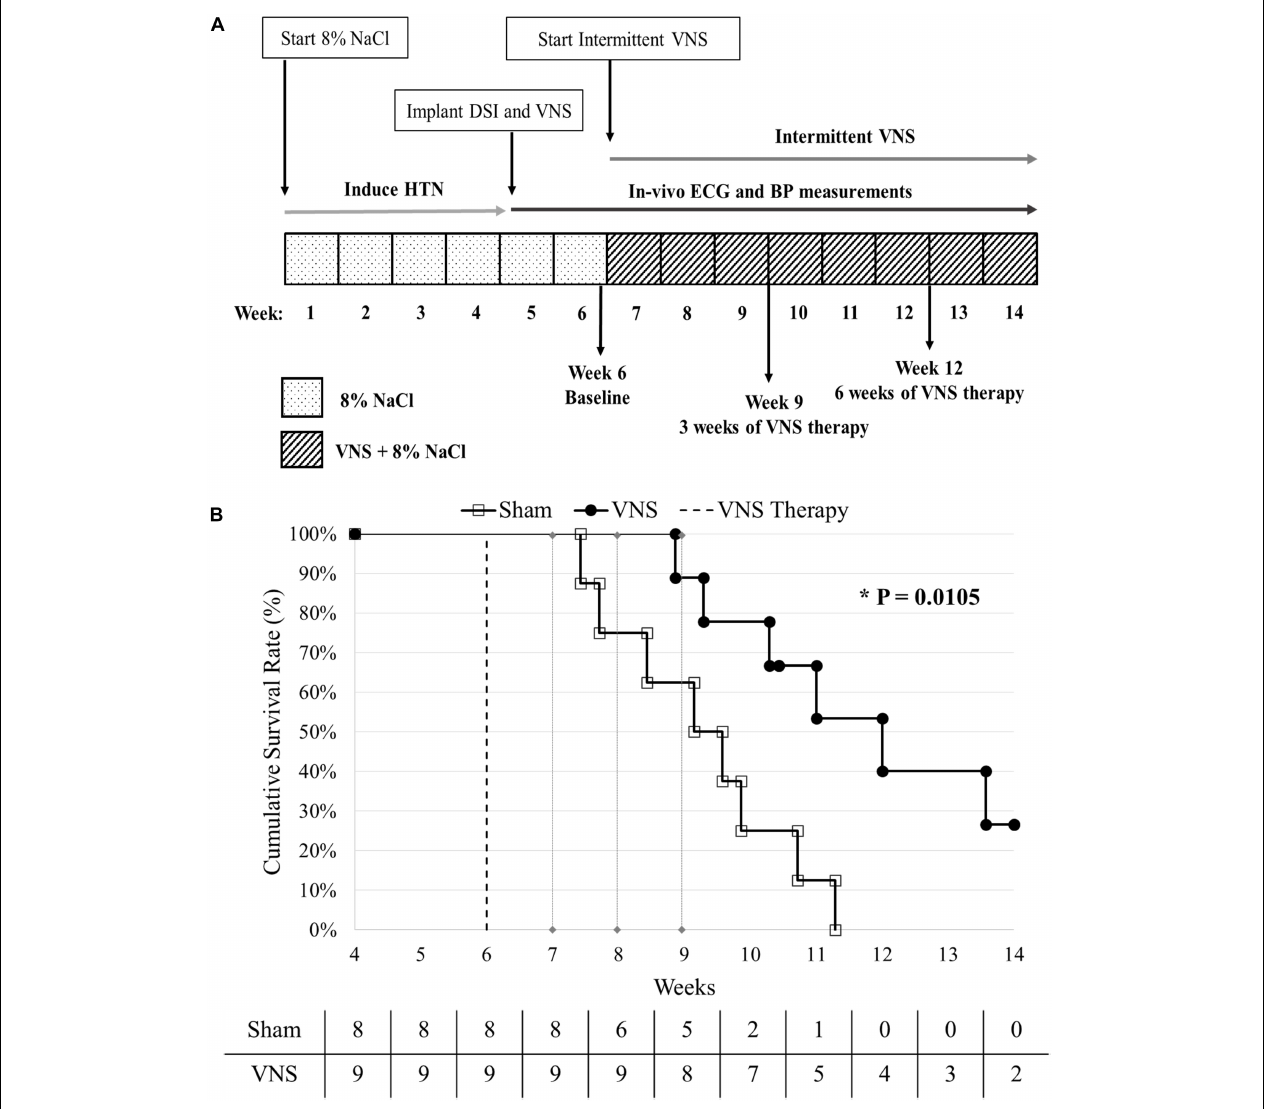
FIGURE 1 | (A) Experimental design. HTN was induced using a high salt diet (8% NaCl). At Week 4, the rats were implanted with vagal nerve stimulators and DSI transmitters, and randomly divided into Sham ( n = 8) and VNS ( n = 9) groups. VNS therapy was turned on at Week 6 and continuous BP and ECG were recorded until the end of the study. (B) Kaplan-Meier event-free survival curves for Sham and VNS rats are statistically different ( P < 0.05). The dashed vertical line indicates the start of VNS therapy at Week 6. The number of rats remaining in each group is included along the x